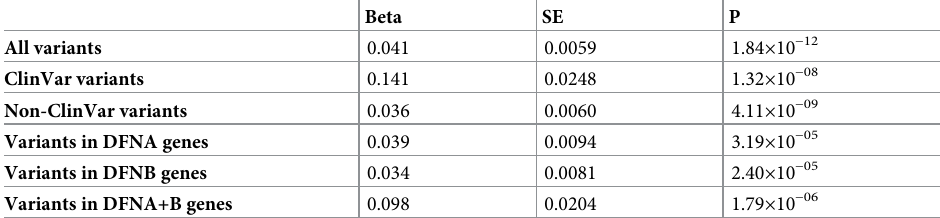
Table 2. Association of total burden in known hearing loss genes with HL in UKB.